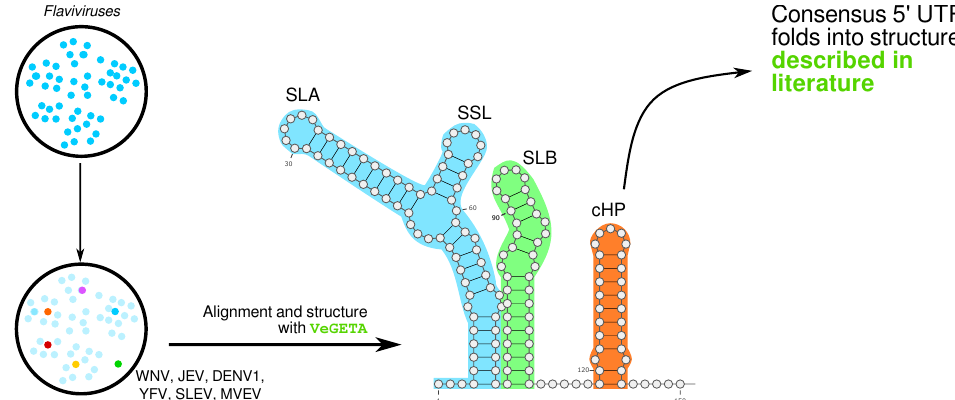
Figure 7. First results of our VeGETApipeline on an example input set consisting of flaviviruses. We were able to identify the West-Nile Virus (WNV), Dengue Virus 1 (DENV1), Japanese Encephalitis Virus (JEV), Yellow Fever Virus (YFW), Saint Louis Encephalitis Virus (SLEV) and Murray Valley Encephalitis Virus (MVEV) as representative viruses from downloaded virus genomes [53]. The resulting alignment calculated by VeGETA has structure annotations for the complete genomes, including 5’ UTR, coding regions and 3’ UTR. Here, we extracted the 5’ UTR from the alignment and visualized the annotated structure elements. These elements agree with the literature [54], as we were able to reconstruct the SLA, SLL, SLBand cHPelements accurately. The first two elements were recognized by the viral replication mechanism (NS5) [55]. The sequence embedded in the SLB structure is known to play a role in the genome circularization of flaviviruses [56], whereas the cHP facilitates the translation of the coding region by pausing the translation machinery and finding the correct starting triplet